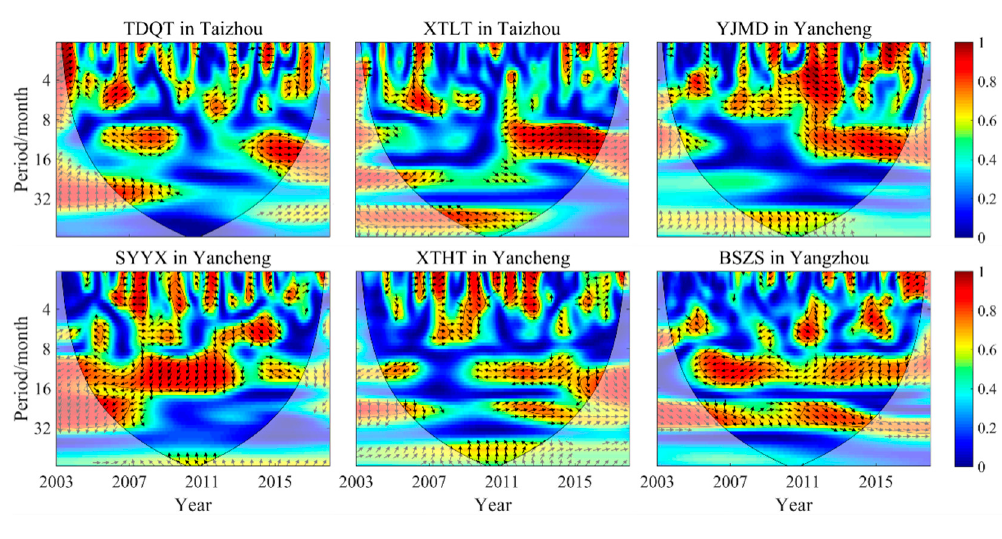
Figure 6. Results of XWT ( a ) and WTC ( b ) of CWQI and water level at six representative stations. The color scale on the right side of the figure represents the density of the cross wavelet power spectrum, and the arrow direction reflects the phase relationship between the CWQI and water level: ‘ → ’ represents the same phase, ‘ ← ‘ represents the opposite phase, ‘ ↓ ‘ represents that the CWQI lags behind the water level by one-quarter of a cycle, and ‘ ↑ ‘ represents that the CWQI advances the water level by one-quarter of a cycle. Table 7. Correlation between the CWQI and water level.